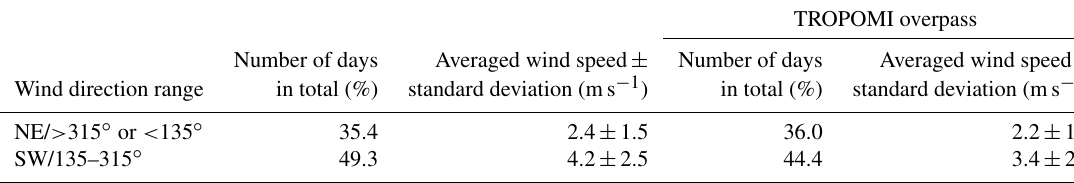
Table A1. Number of days and the averaged wind speed ( ± standard deviation) per specific wind area in daytime (08:00–18:00UTC) from 10 November 2017 to 11 September 2020 measured at the Cuatro Vientos Airport. Columns 2 and 3 are for all days, and columns 4 and 5 are for days with TROPOMI overpass.